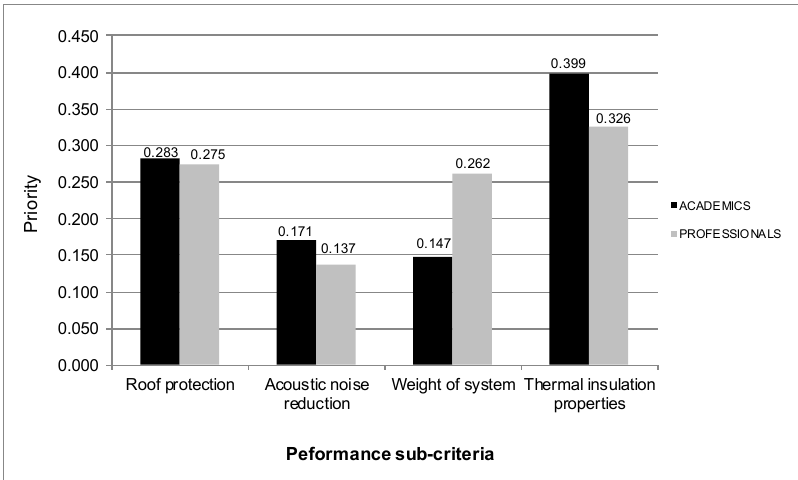
Figure 7. Priorities assigned to “Performance” sub-criteria by Academics and Professionals.